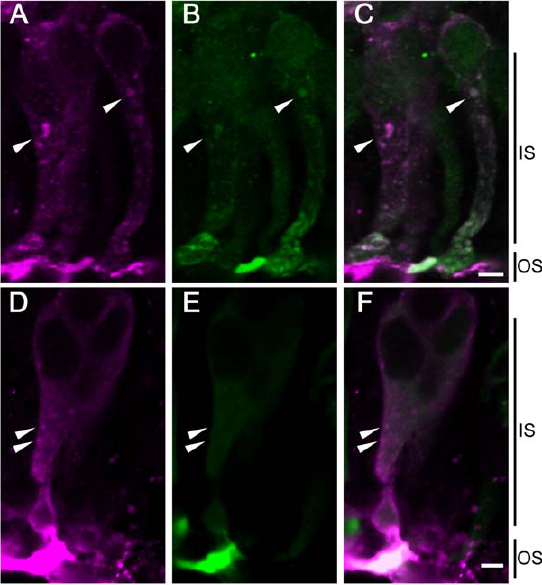
Figure 6. Confocal images showing localization of parapinop- sin, b -arrestin and G protein under UV light. Panels A and D: Immunoreactivity to parapinopsin (magenta); panel B: immunoreactiv- ity to b -arrestin (green); panel C: merged image of A and B; panel E: immunoreactivity to G proteins (green) and F: merged image of D and E. Parapinopsin and b -arrestin colocalized to the granules of the inner segments (arrowheads in A–C), whereas no G protein immunoreactivity was distributed in the granules of the inner segments, in which parapinopsin was localized (arrowheads in D–F). IS, inner segment; OS, outer segment. Scale bars, 10 m m.